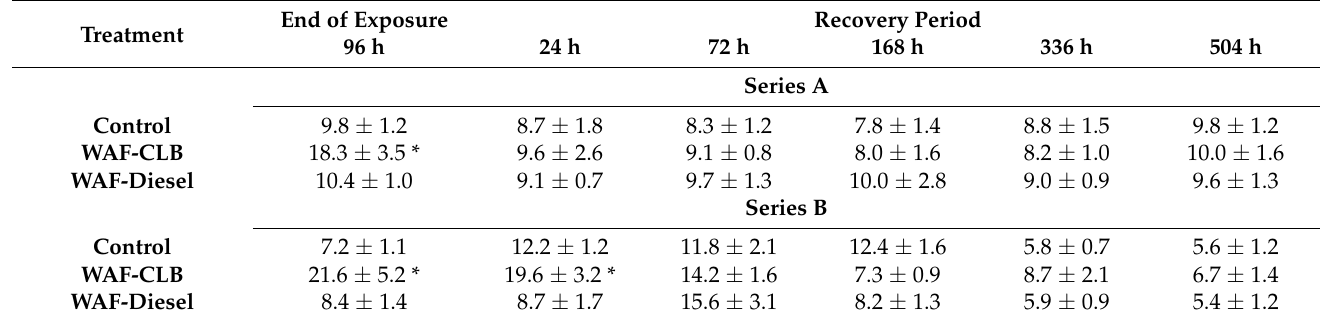
Table 4. Fraction of nonviable lobster’ hemocyte cells for each treatment (Control, WAF-CLB, and WAF-Diesel) during the recovery period in series A and B. Mean ± SE; n = 3. Treatment